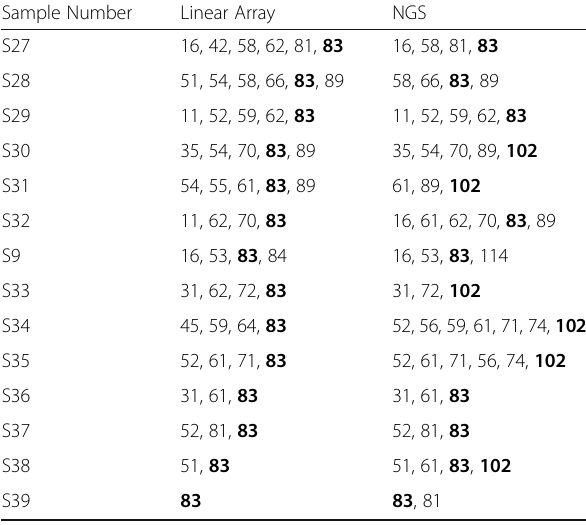
Table 2 HPV genotyping by NGS of 14 cervical samples